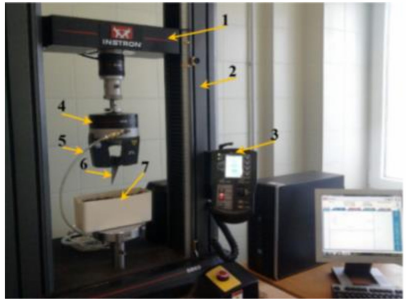
Figure 4. Device for determining the mechanical properties of plant residues “Instron 5960”: 1—upper stroller; 2—frame; 3—control panel; 4—grabs of knife; 5—tube of air supply to grabs; 6—60 ◦ angled knife; 7—box with the